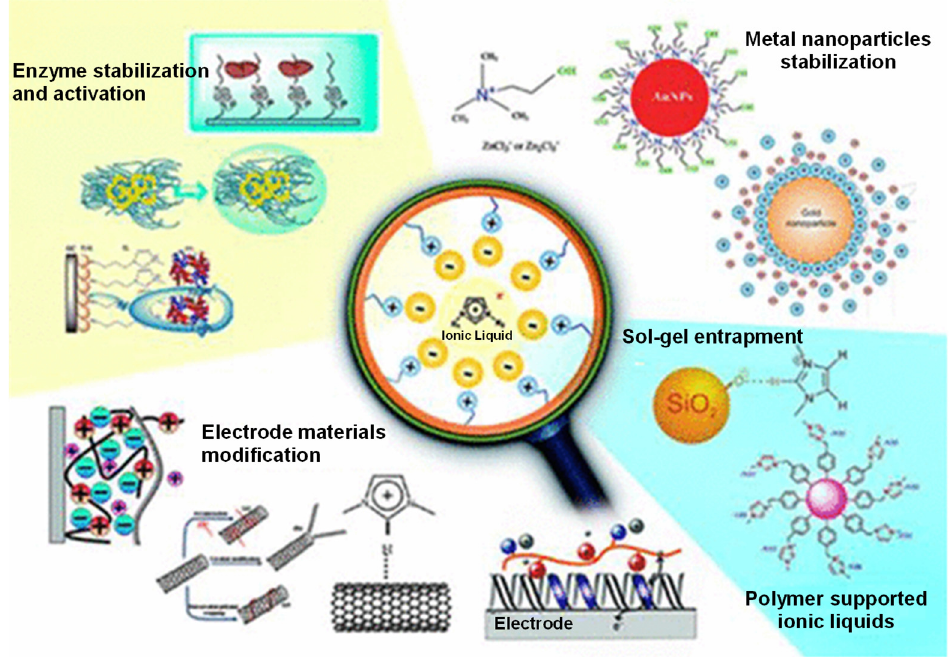
Figure 1. (Bio)technological applications of ionic liquid-based electrochemical systems. Reprinted from Ghorbanizamani and Timur [5]. Copyright 2018—American Chemical Society.